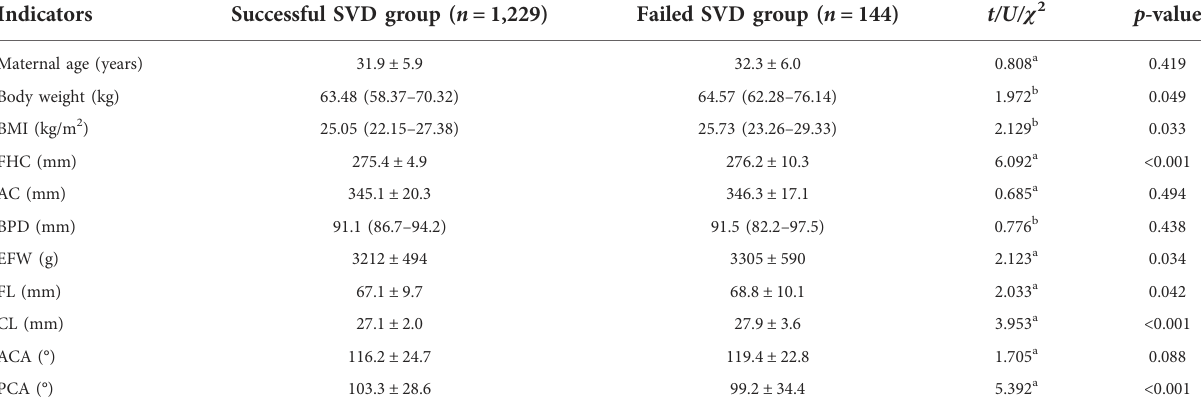
TABLE 2 Perinatal characteristics and antepartum ultrasound parameters between successful and failed SVD groups.